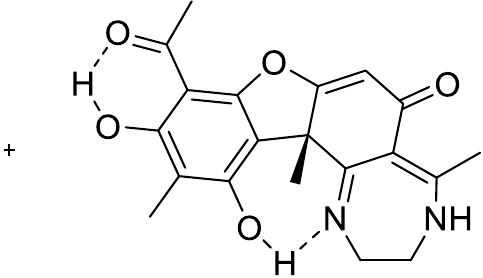
Figure 15. Usnic acid with cyclic extension. From Ref. [63].